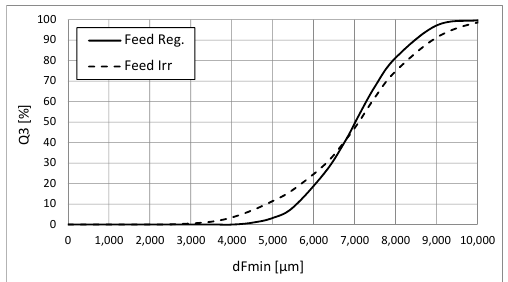
Figure 12. Cumulative particle size distribution functions of chalcedonite feed with regular (Reg) and irregular (Irr) particles.